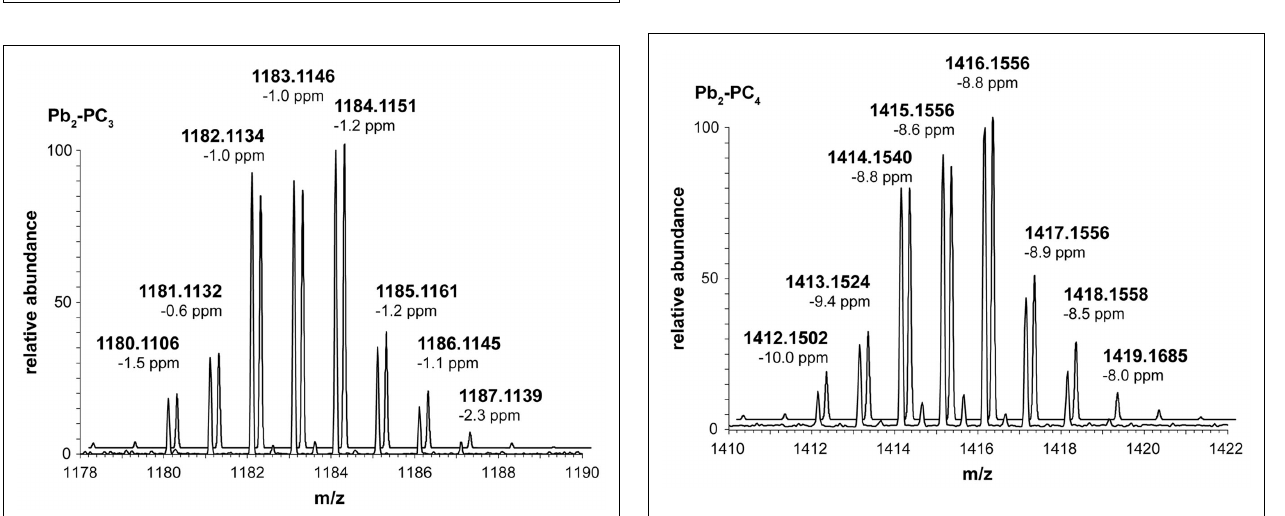
FIGURE 4 | Measured (front) and simulated spectrum (back) of the isotopic pattern of the [Pb–PC 3 ] + complex m / z 972–984. Isotopic distribution of Pb ( 204 Pb 1.5; 206 Pb 23.6; 207 Pb 22.6; 208 Pb 52.3%) is identified in the peak distribution at m / z 974.15, 976.15, 977.15, and 978.16.